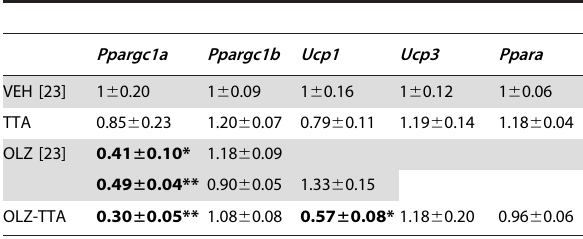
Table 7. Relevant genes examined in brown adipose tissue (BAT) in the chronic study.